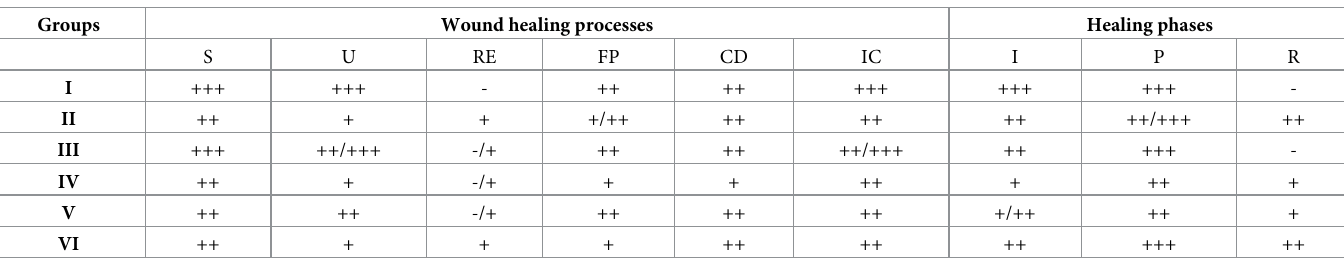
Table 2. Wound healing processes and healing phases of the animals administered different treatments on day 7. Groups Wound healing processes Healing